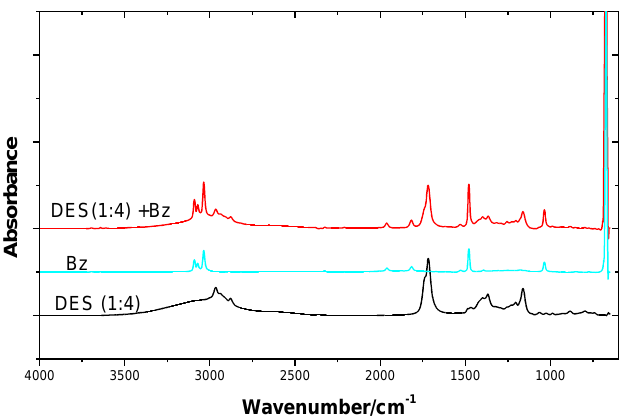
Figure 18. FT − IR spectra of DES(1:4), benzene and DES(1:4) + benzene(DES 0.1 (molar concentra- tion)). From Figure 17, the FT-IR spectra of DES(1:1–1:4), benzene and DES(1:1–1:4) + ben- zene shows the peak corresponding to the hydroxy v(OH) group at 3200 cm −1 and the peak ascribed to the carboxyl group v(C=O) at 1722 cm −1 . In the mixture containing DES(1:1–